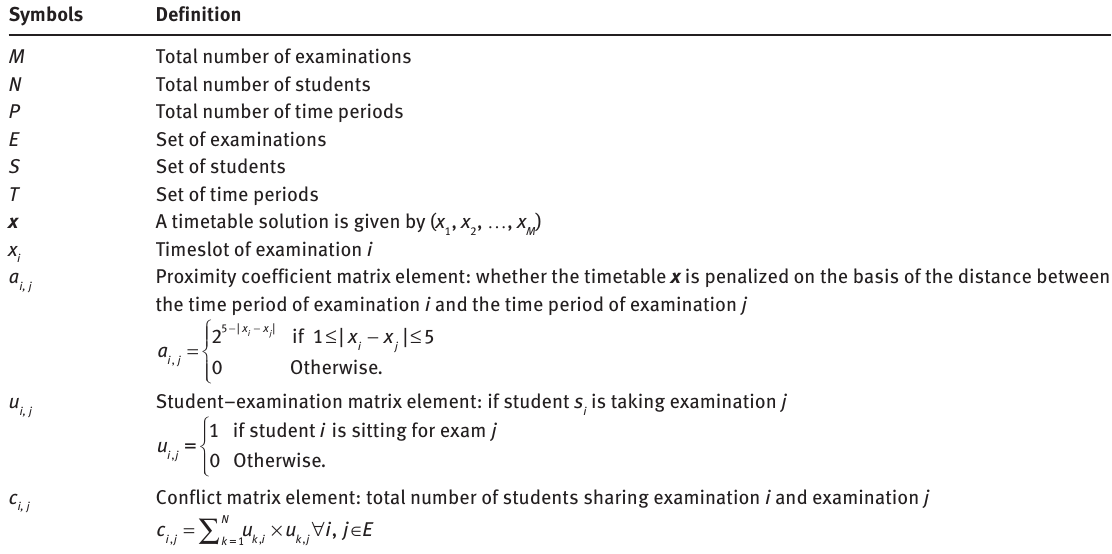
Table 1. Symbols Used in the Description of